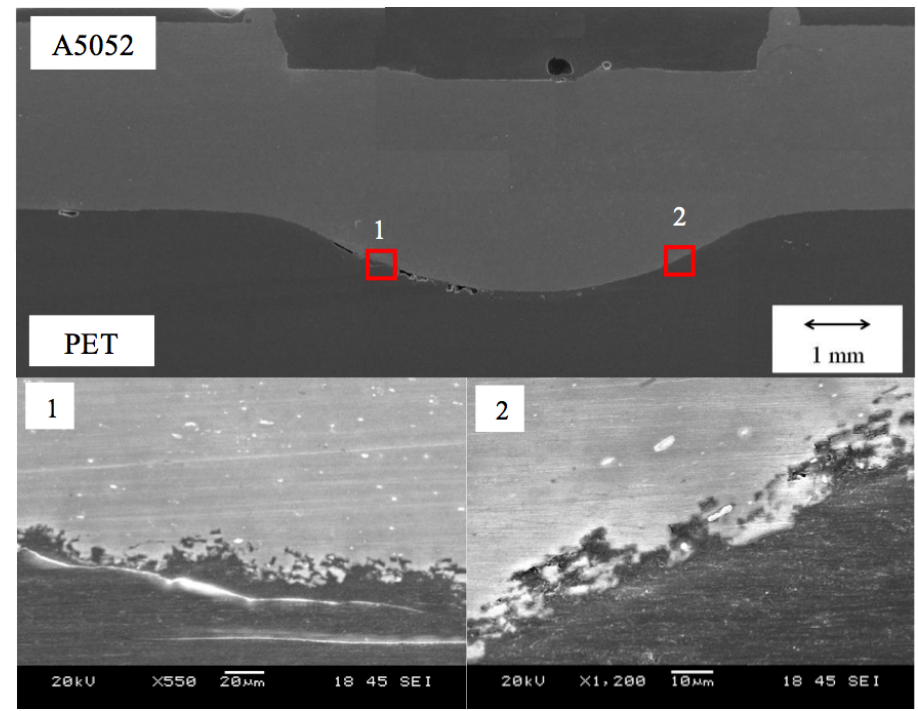
Figure 9. Cross-sectional observation of A5052(E6)-PET specimen joint at plunge speed of 20 mm/min and plunge depth of 0.7